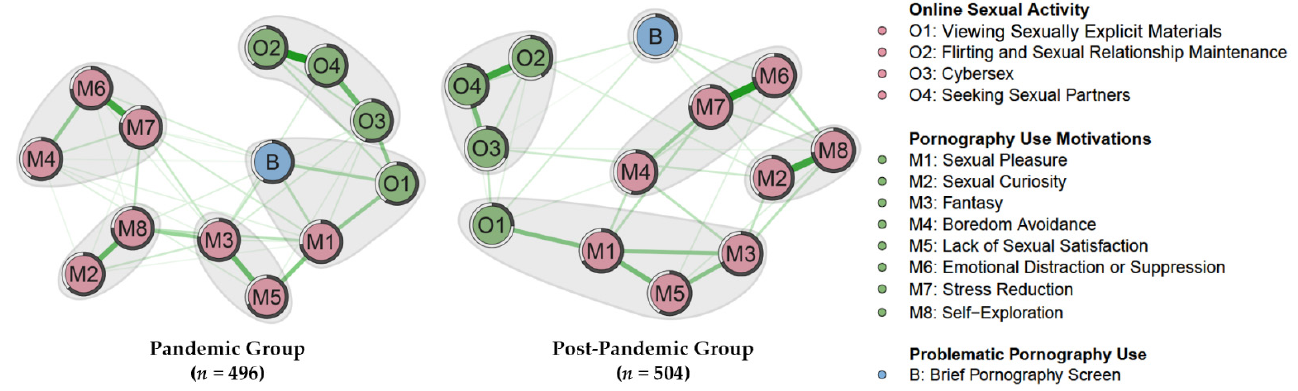
Figure 3. Community of nodes based on spinglass algorithm, visualized on the MGM networks by